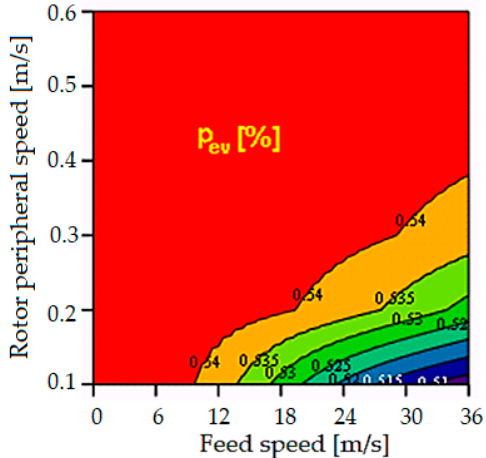
Figure 10. Graphic representation of evacuation losses ( p ev ) as a function of rotor peripheral speed ( v p ) and feed speed ( v a ).